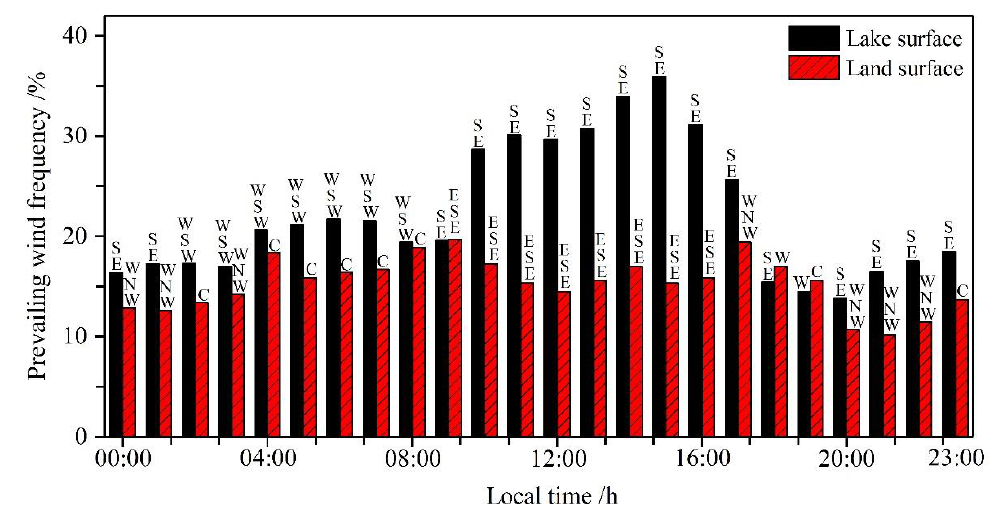
Figure 6. Diurnal variations in prevailing wind frequency over the lake surface and land surface in the Erhai Lake basin (adapted from [51]).